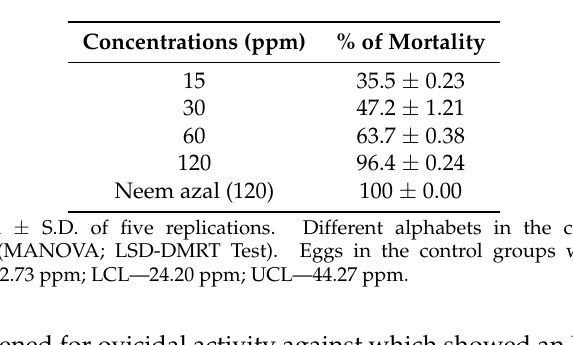
Table 2. Ovicidal activity by green synthesized ZnO